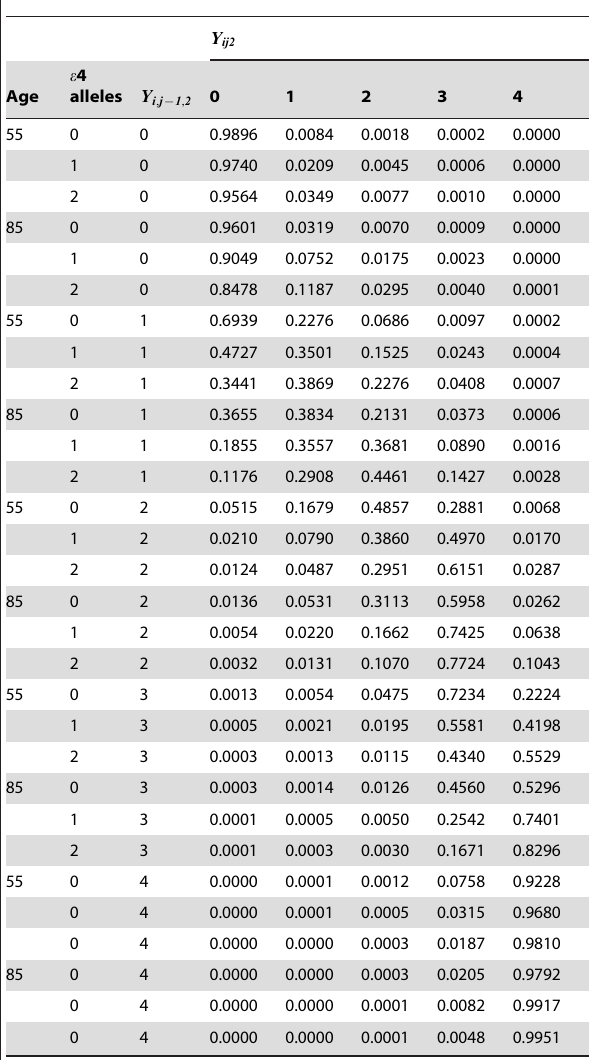
Table 3 . The estimated transition probability matrix of clinical dementia rating (CDRGLOB) in Alzheimer’s disease patients at the age of 55 or 85 and carrying no, one, or two APOE- e 4